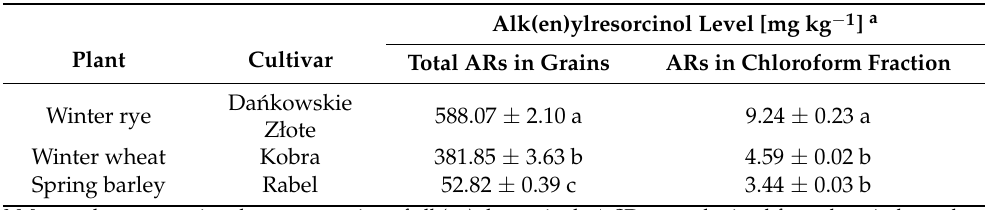
Table 3. The ability of chloroform to remove 5- n -alk(en)ylresorcinols from the caryopsis surface of various cereals.